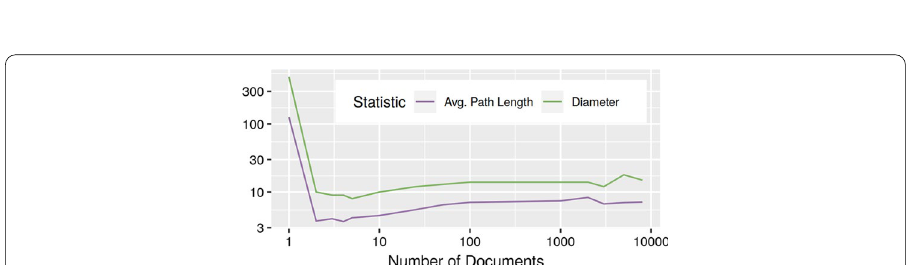
Fig. 5 Average estimated diameter and average shortest path over time for the base model